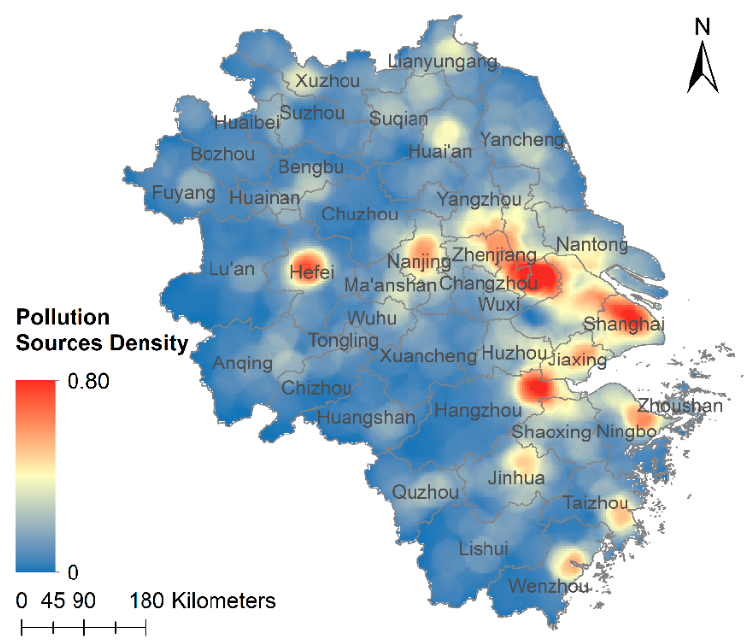
Figure 9. Pollution sources density map.